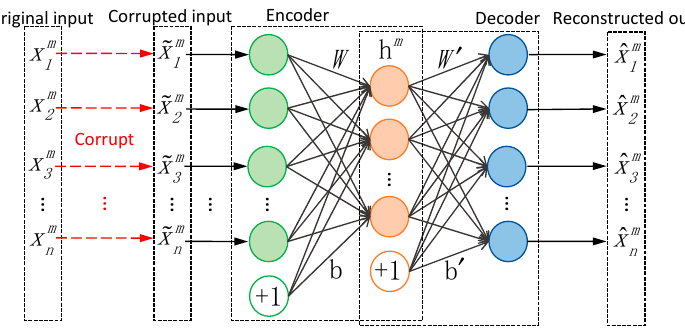
Figure 1. Structure of traditional denoising autoencoder: the learning target is minimizing the error between the reconstructed output and the original input.